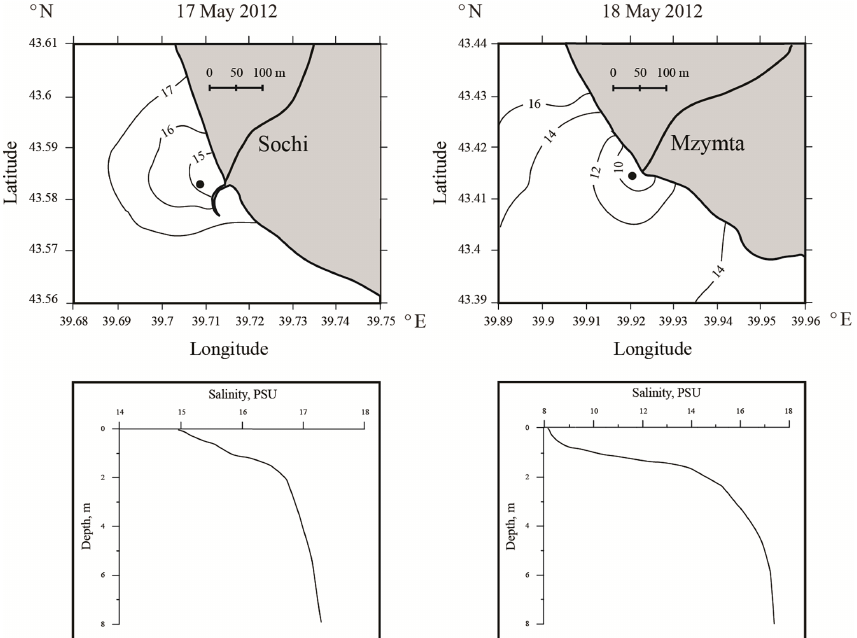
Figure 2. Surface salinity distributions (top panel) and vertical salinity profiles (bottom panel) at the Sochi plume on 17 May 2012 (left) and at the Mzymta plume on 18 May 2012 (right).